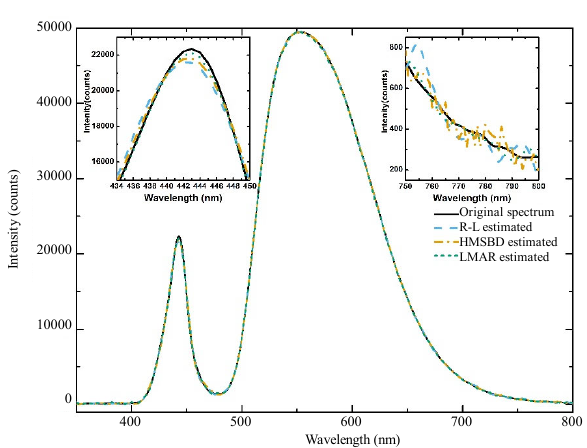
Fig. 10 Original spectrum and corrected spectra of white LED 2#.